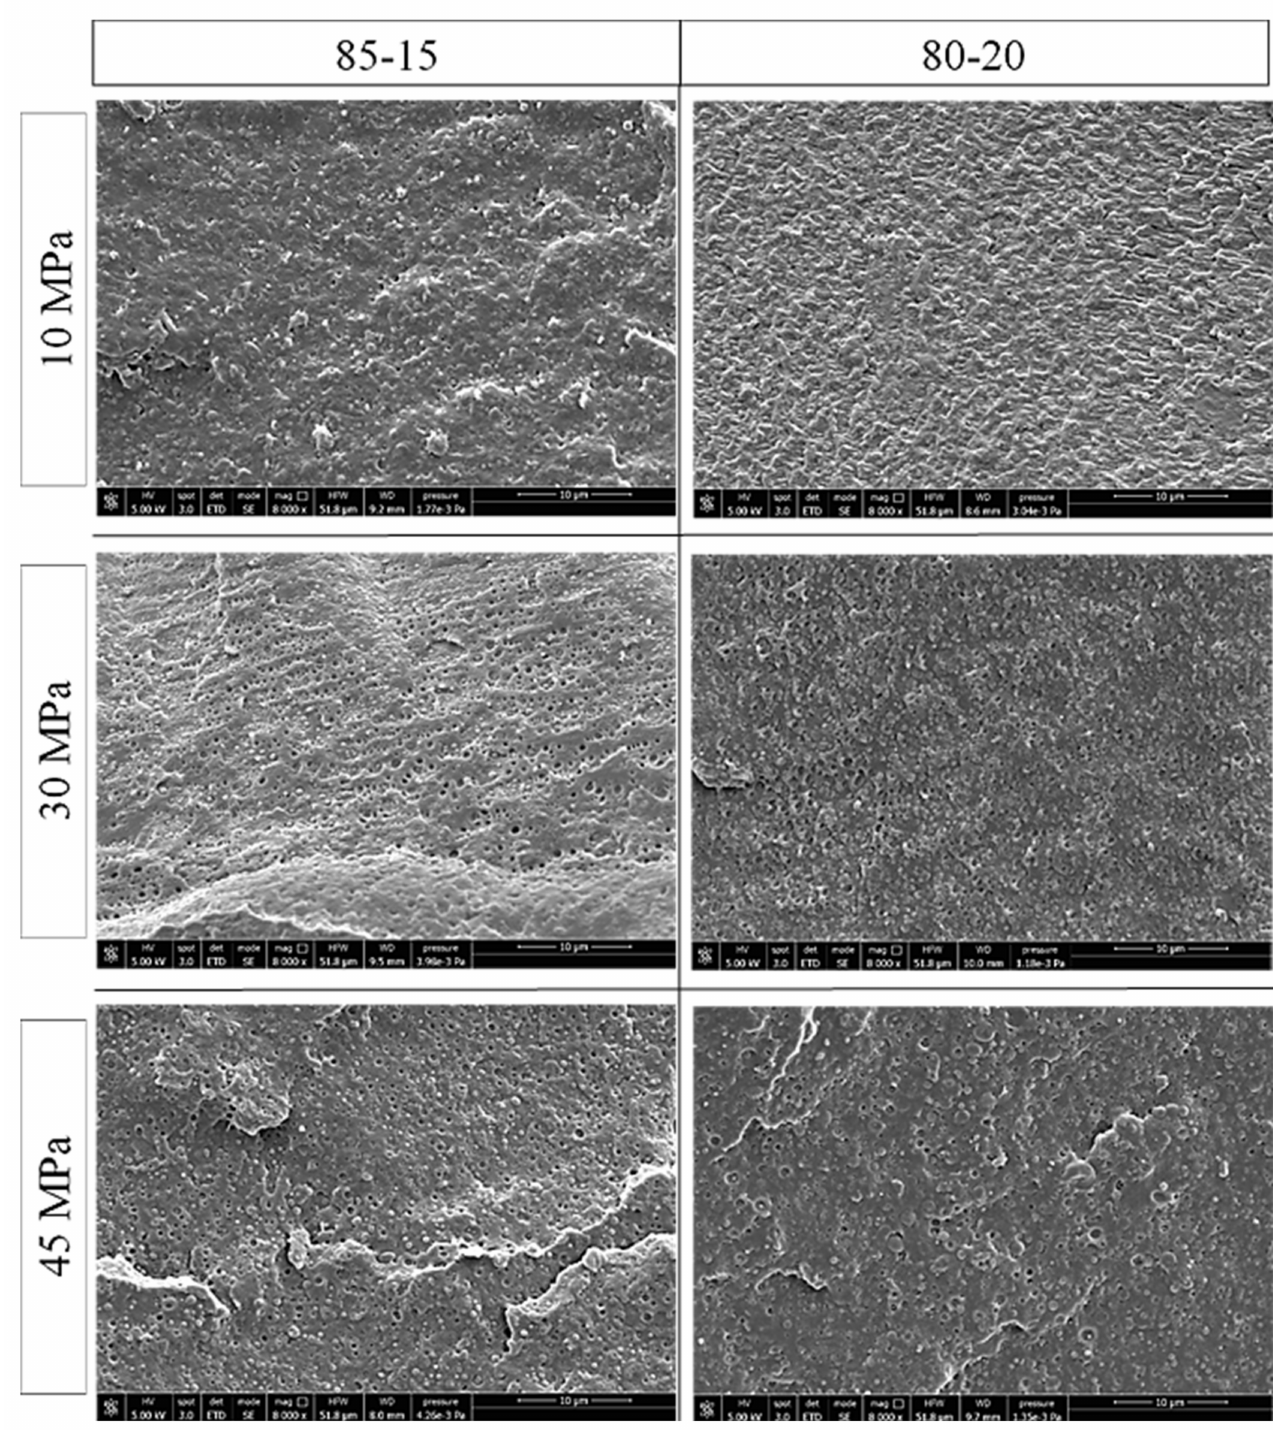
Figure 6. SEM micrographs made at the surface of tensile specimen cryo-fractured along the draw direction at different creep stress